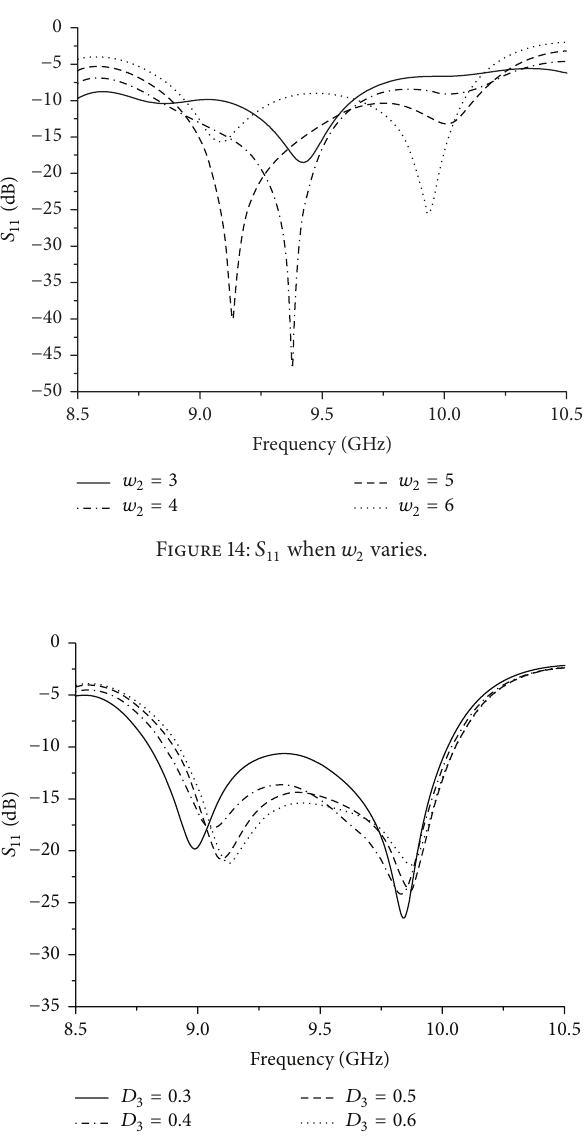
Figure 15: 𝑆 11 when 𝐷 3